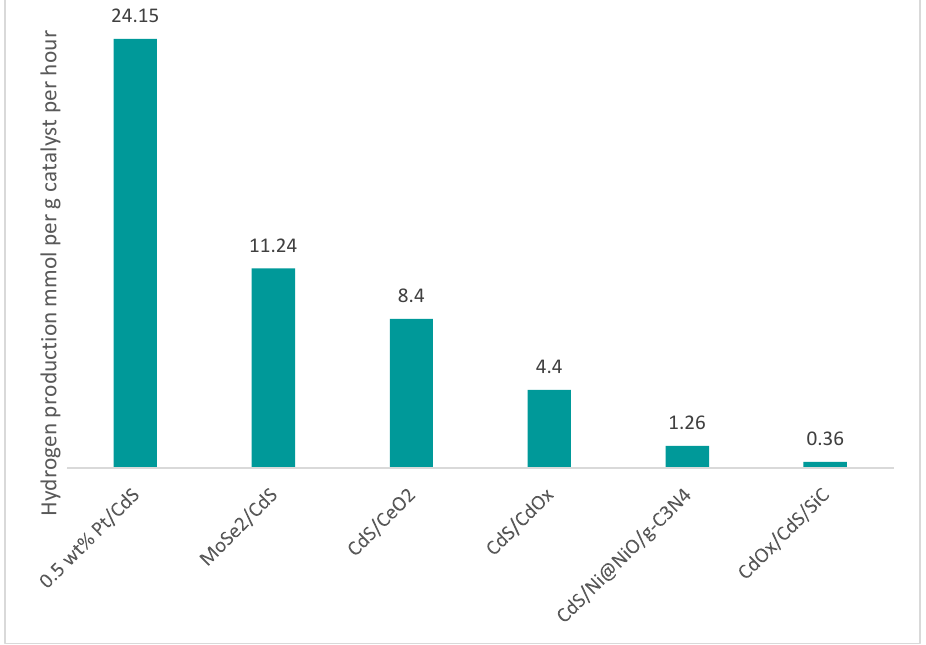
Figure 1. Photocatalytic (CdS-based) hydrogen evolution rates. Only two studies concerning CdS photocatalyst showed hydrogen evolution from lignocelluloses greater than 0.36 mmol · g ·h −1 [6,7]. An organic waste substrate could